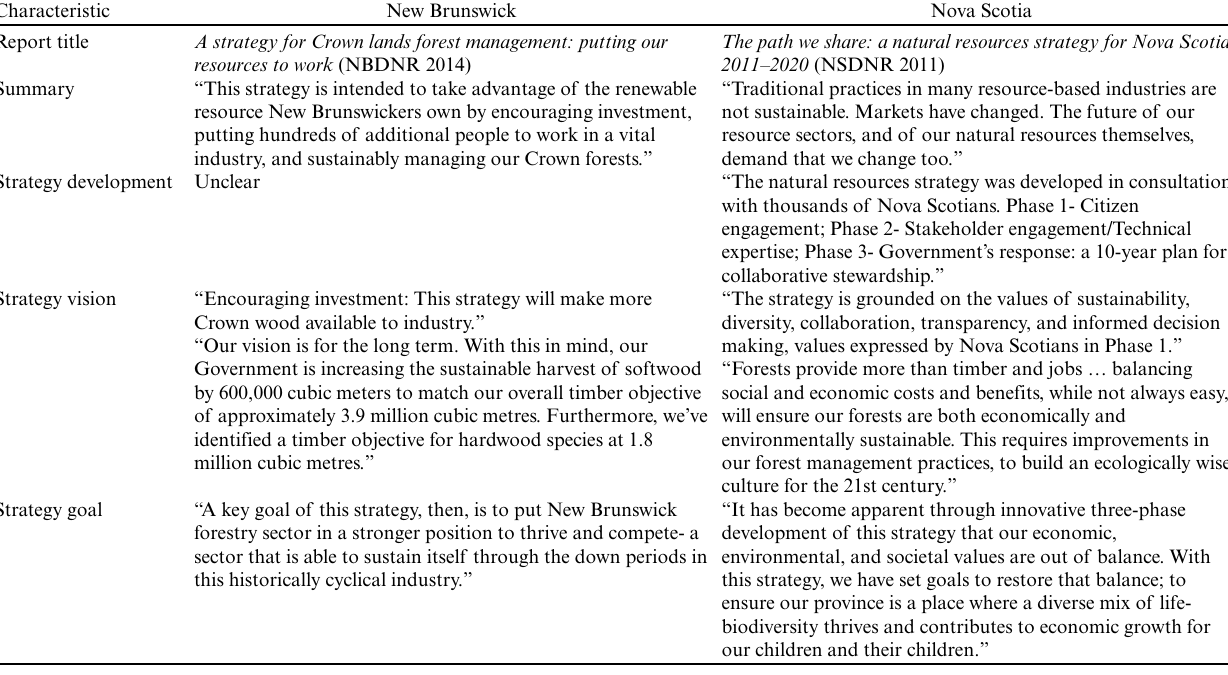
Table 6. Comparison of recent forest strategies in New Brunswick and Nova